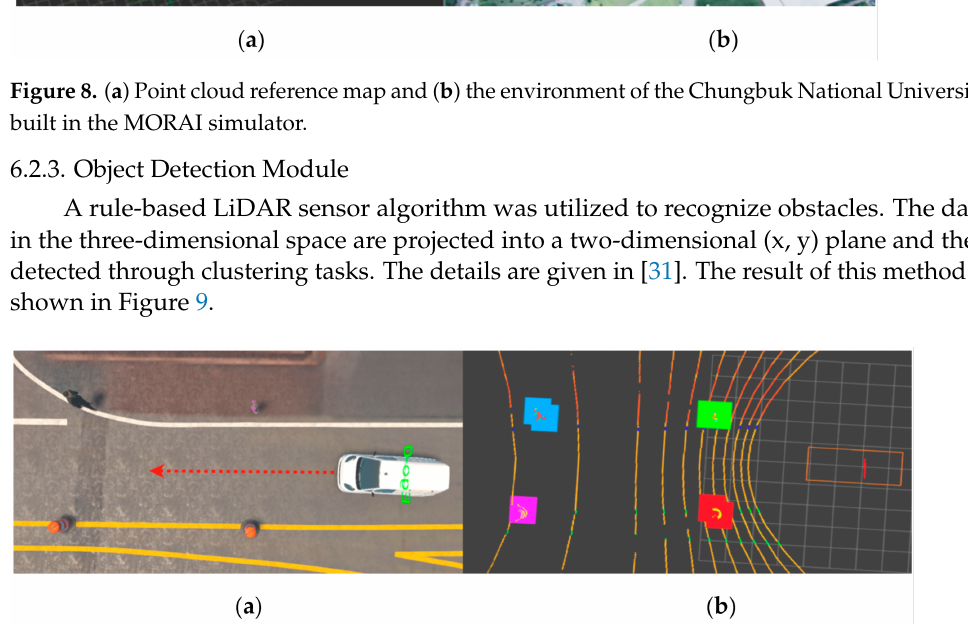
Figure 9. Result of object detection based on LiDAR tested on a simulator: ( a ) Obstacle environment of simulator; and ( b ) the image displaying detected obstacles on the RVIZ tools. The detected obstacles are denoted as big boxes and the small lines refer to the 3D point clouds.